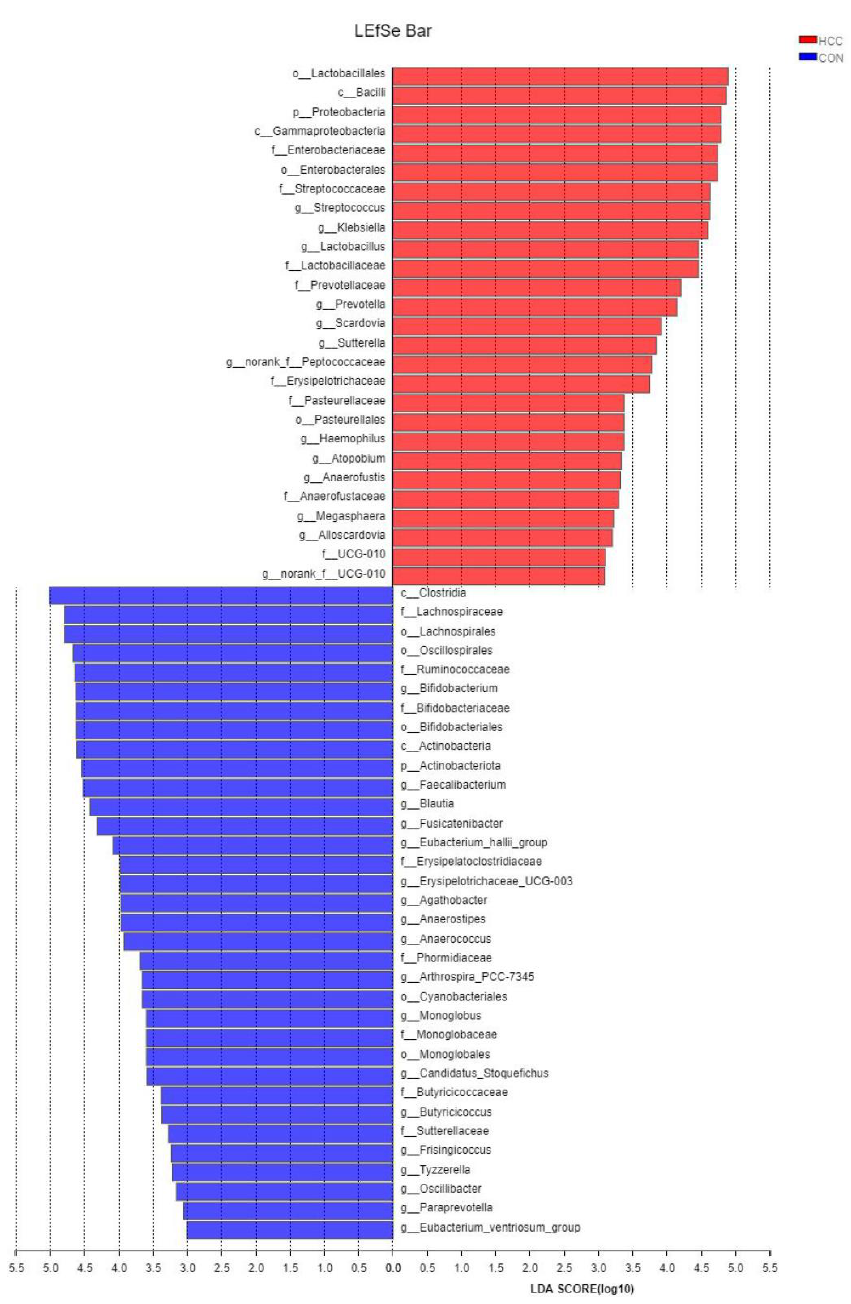
Figure 3. LDA discriminant histogram shows differences detected between HCC group and CON group, with LDAvalue > 3, and one-against-all was adopted to compare two groups.